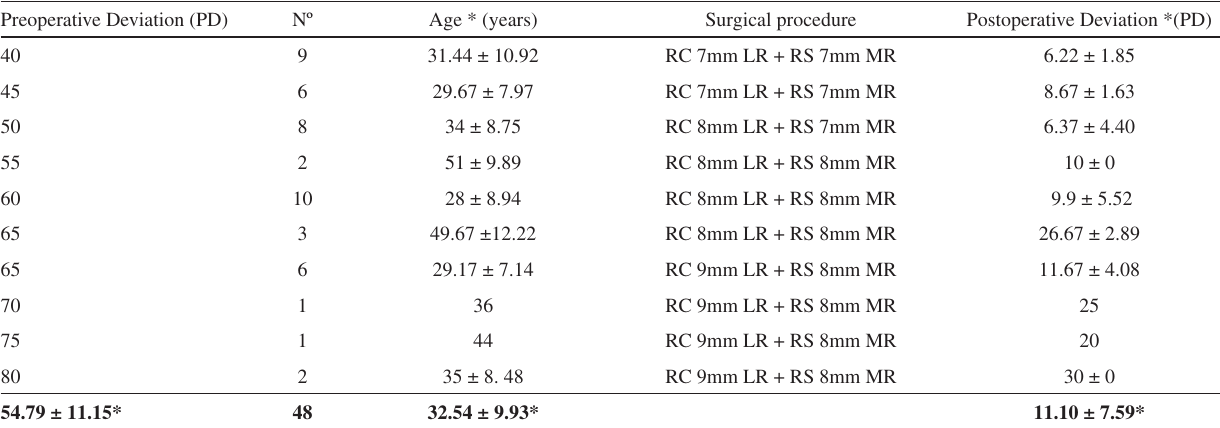
Table 2 - Characteristics of group 2 (exotropia) Preoperative Deviation (PD) Nº Age * (years) Surgical procedure Postoperative Deviation *(PD)